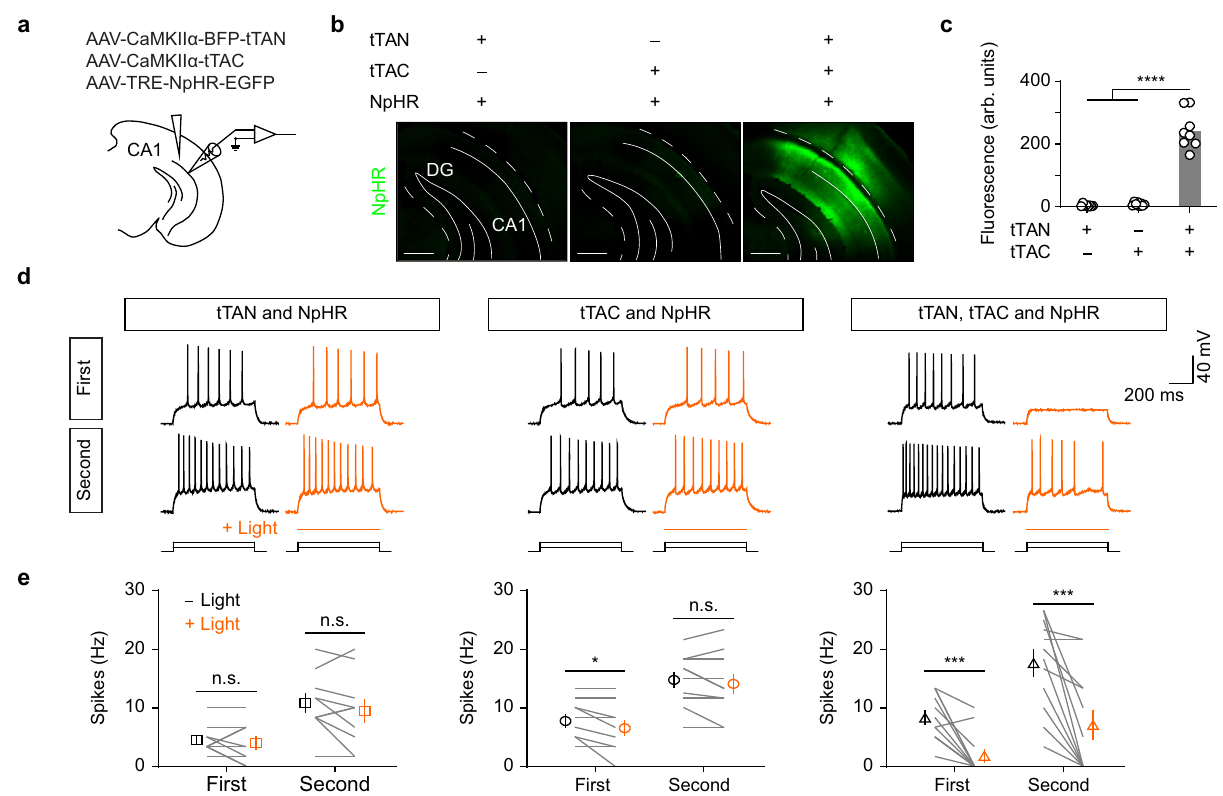
Fig. 3 The IBIST-based optogenetic inhibition. a Scheme depicting AAV injections into hippocampus. b Examples showing GFP fl uorescence in hippocampus after injected with AAV-TRE-NpHR and AAVs (CaMKII α promoter) of tTAN, tTAC or both, respectively. Scale bars: 500 µ m. c , Summary of fl uorescent intensity in b . One-way ANOVA revealed signi fi cant fl uorescence differences between groups (F = 123.1, **** P = 2.52 × 10 − 12 ) and (2,21) Turkey ’ s multiple comparisons revealed that the fl uorescence is signi fi cantly higher in tTAN + tTAC group than in others (**** P < 0.0001 for all). N = 2 animals for each group. d Examples showing whole-cell current-clamp recording from hippocampal cells in brain slices upon current injections with 40 pA steps ( fi rst and second sweeps with prominent spikes; yellow with light; black without light). e Frequency of spikes in hippocampal cells in the absence (black) or presence (yellow) of 589 nm laser light (18 mW) from animals injected with AAV-TRE-NpHR and other CaMKII α AAVs. The tTAN + tTAC animals showed a signi fi cant decrease in frequency of spikes after light stimulation (Wilcoxon matched-pairs signed rank test; fi rst sweep, 8.3 ± 1.1 Hz vs. 1.8 ± 1.0 Hz with light; *** P = 0.001; second sweep, 17.6 ± 2.3 Hz vs. 7.1 ± 2.5 Hz, *** P = 0.001; n = 12 cells, N = 2 animals). The tTAN animals, paired t -test; fi rst sweep, 4.5 ± 0.7 Hz vs. 4.0 ± 1.1 Hz with light, P = 0.5414; second sweep, 10.8 ± 1.6 Hz vs. 9.5 ± 2.0 Hz with light; P = 0.21; n = 10 cells, N = 2 animals. The tTAC animals, paired t -test; fi rst sweep, 7.7 ± 1.0 Hz vs. 6.5 ± 1.2 Hz with light, * P = 0.04; second sweep, 14.8 ± 1.3 Hz vs. 14.1 ± 1.5 Hz with light, P